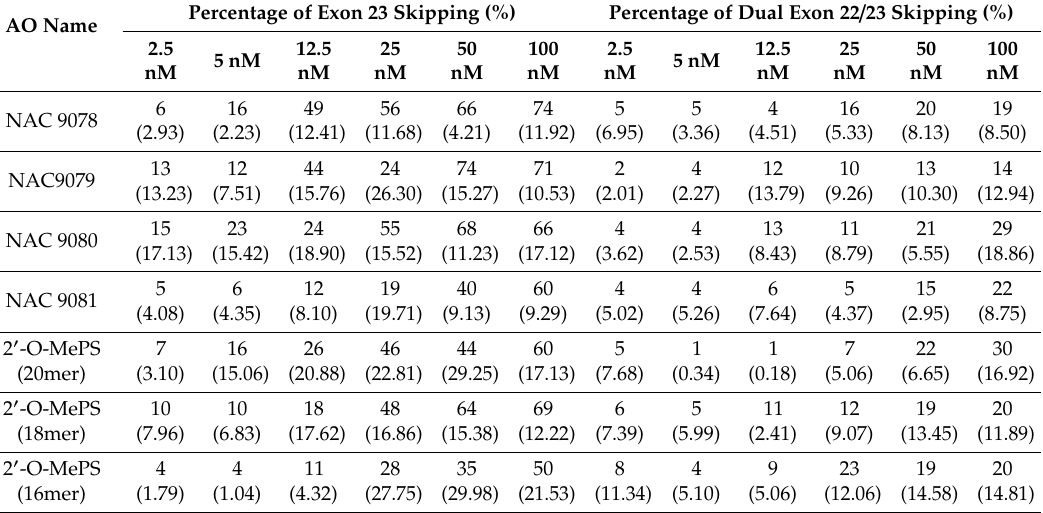
Table 2. Summary of the percentage of exon 23 skipping and dual exon 22 / 23 skipping induced by the AOs. The mean of three repeats are represented in the table. Standard deviation is mentioned in brackets.